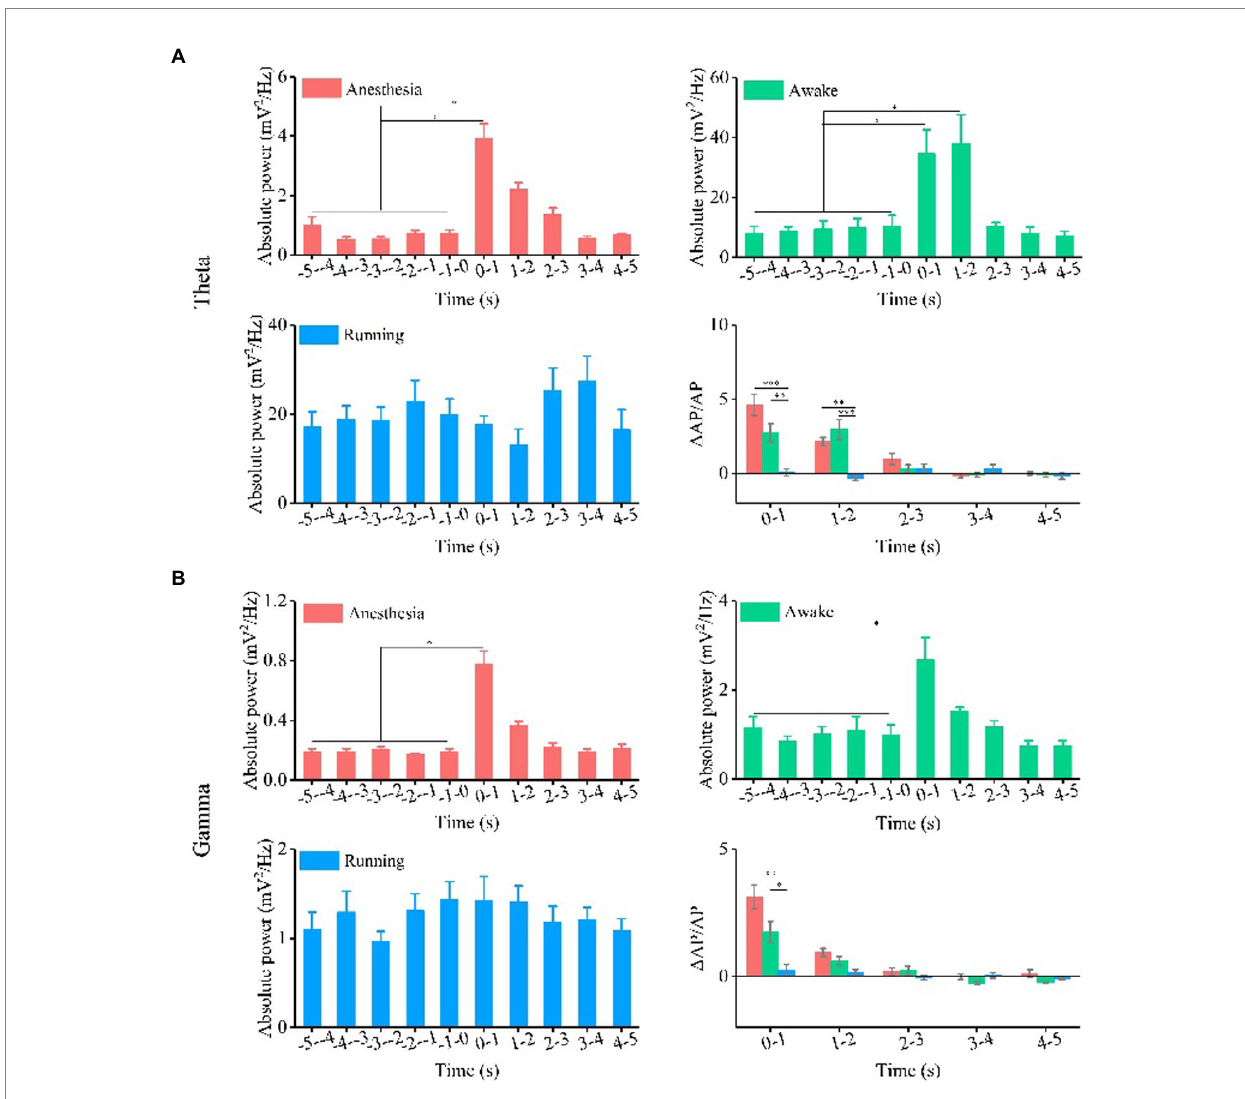
FIGURE 3 Absolute power and relative change of absolute power of theta and gamma oscillation under the anesthesia, awake state, and running state. (A) Theta oscillation. (B) Gamma oscillation. ( N = 7 for each state, mean ± SEM, * p < 0.05, ** p < 0.01, *** p < 0.001, Kruskal–Wallis test with post-hoc pairwise